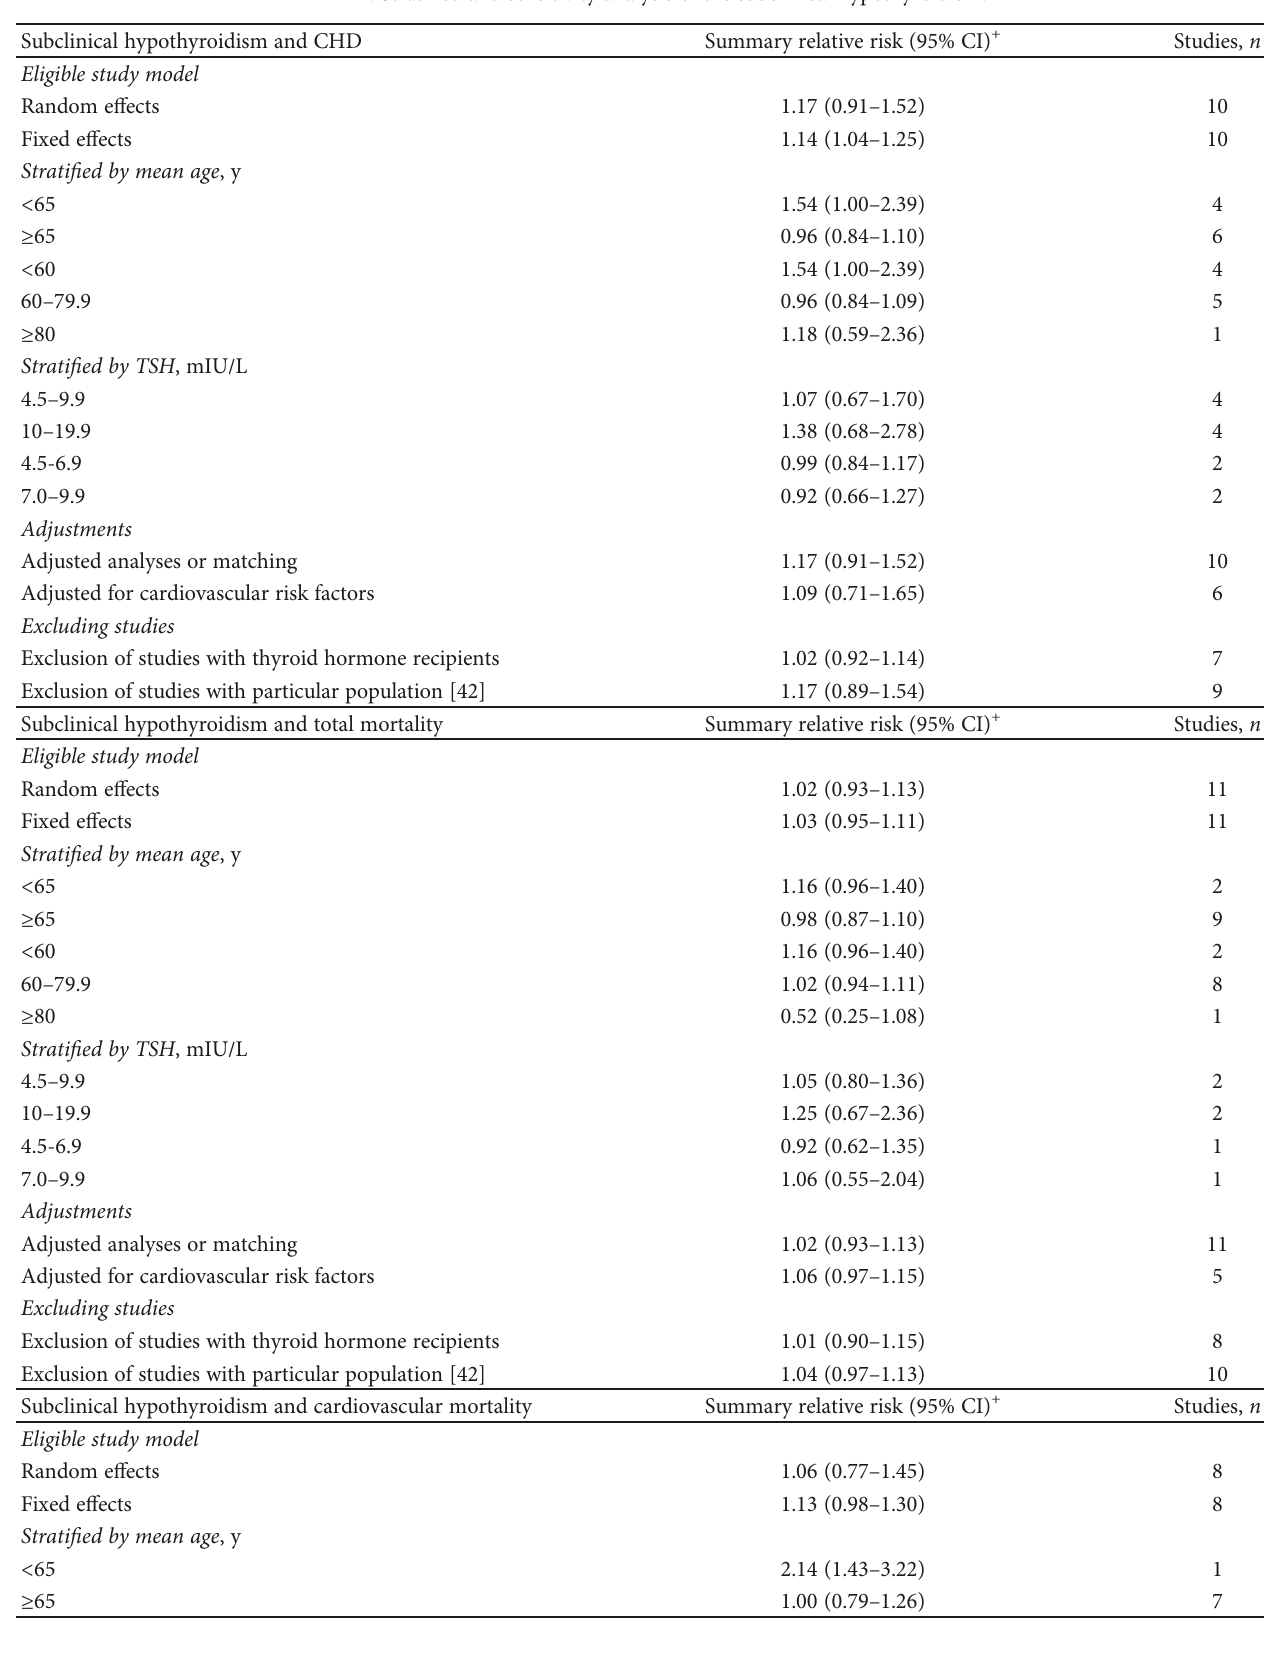
Table 2: Strati fi ed and sensitivity analysis of the subclinical